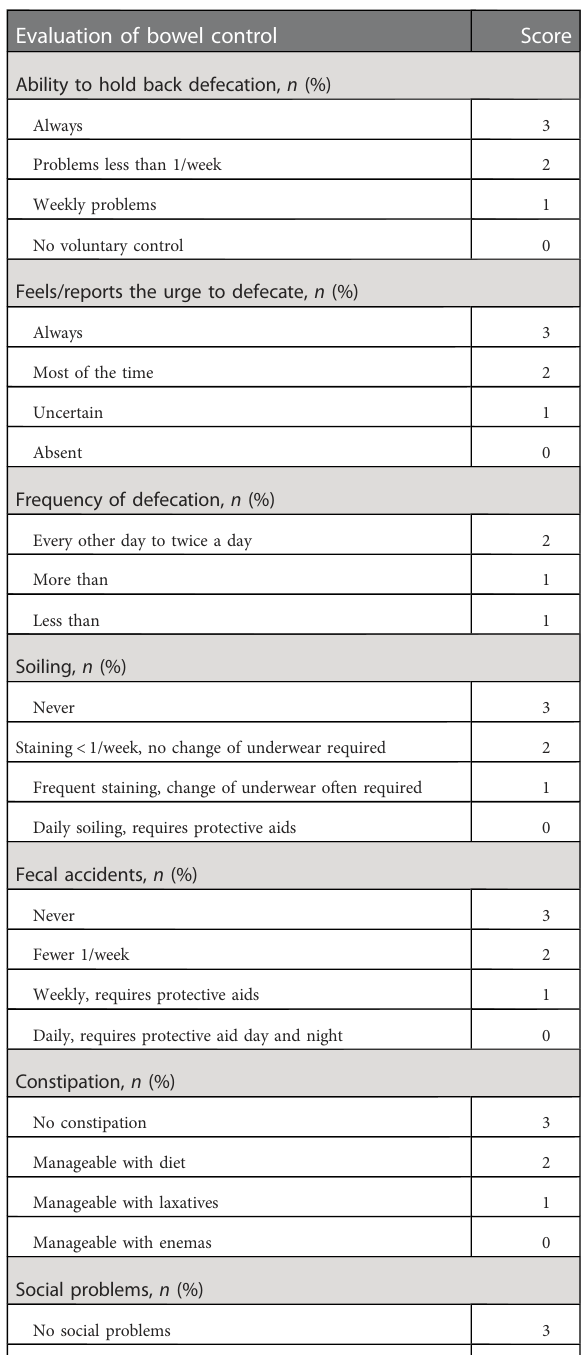
TABLE 1 Bowel function score questionnaire (>4 years old). Evaluation of bowel control